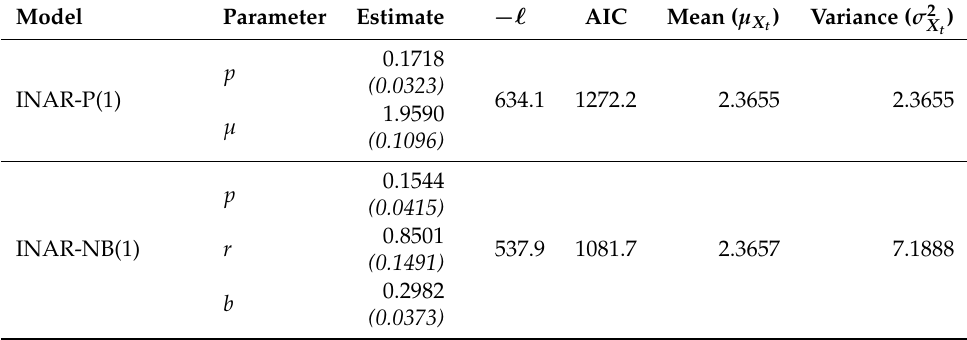
Table 1. Estimated parameters (with standard errors in italics and parentheses), goodness of fit statistics, fitted mean, and fitted variance of considered models for the downloads